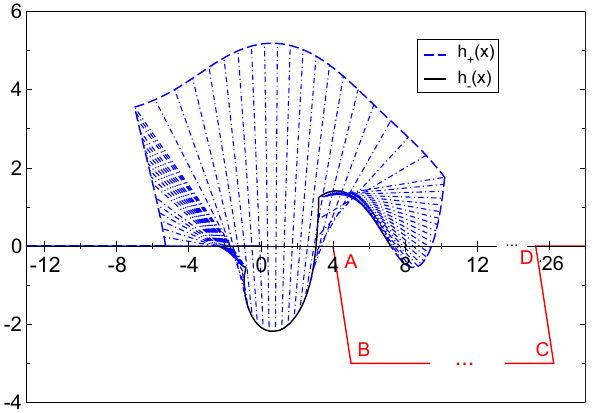
Fig. 6 Displayedaresomestraightlines(dash–dotted)thatconnectthe lower and upper ends h ± ( x ) in the angular averages (4), see also Fig. 5. Axes in units of M 2 π . The eta mass is real. It is seen that the dash– dotted lines do not cross the path ABCD and hence they stay within the holomorphy domain of the amplitudes M I ( s ) . One can therefore perform the angular averages in their original form